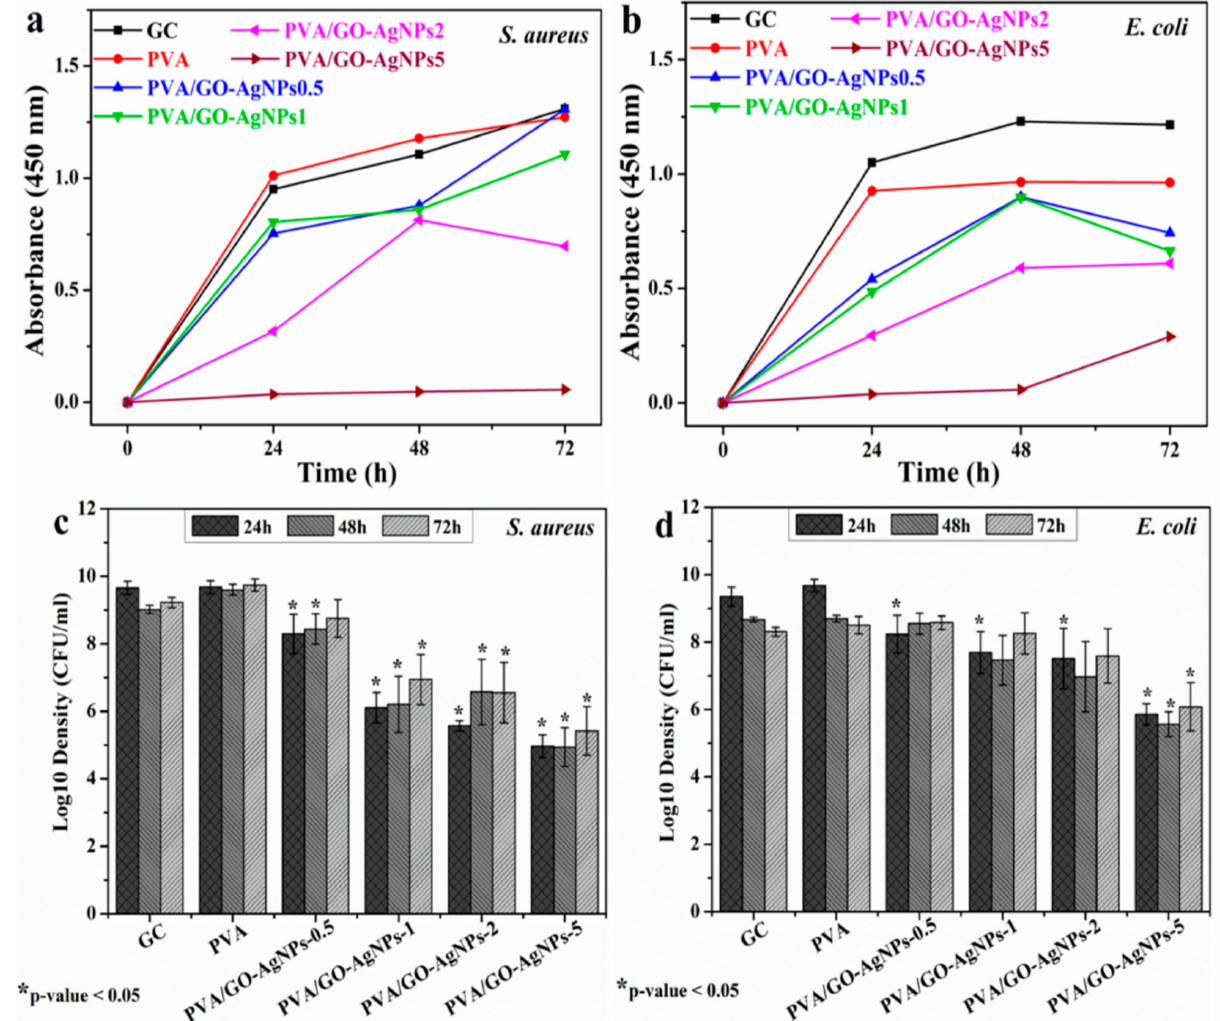
Figure 2. Absorbance vs. time curves for S. aureus ( a ) and E. coli ( b ) after exposure to PVA/GO-AgNPs composite films. Viable counts of S. aureus ( c ) and E. coli ( d ). Samples are labelled as PVA/GO-AgNPsx, where x denotes the wt% of the Go-AgNPs filler. Reprinted with permission from ref. [49]. Copyright 2021